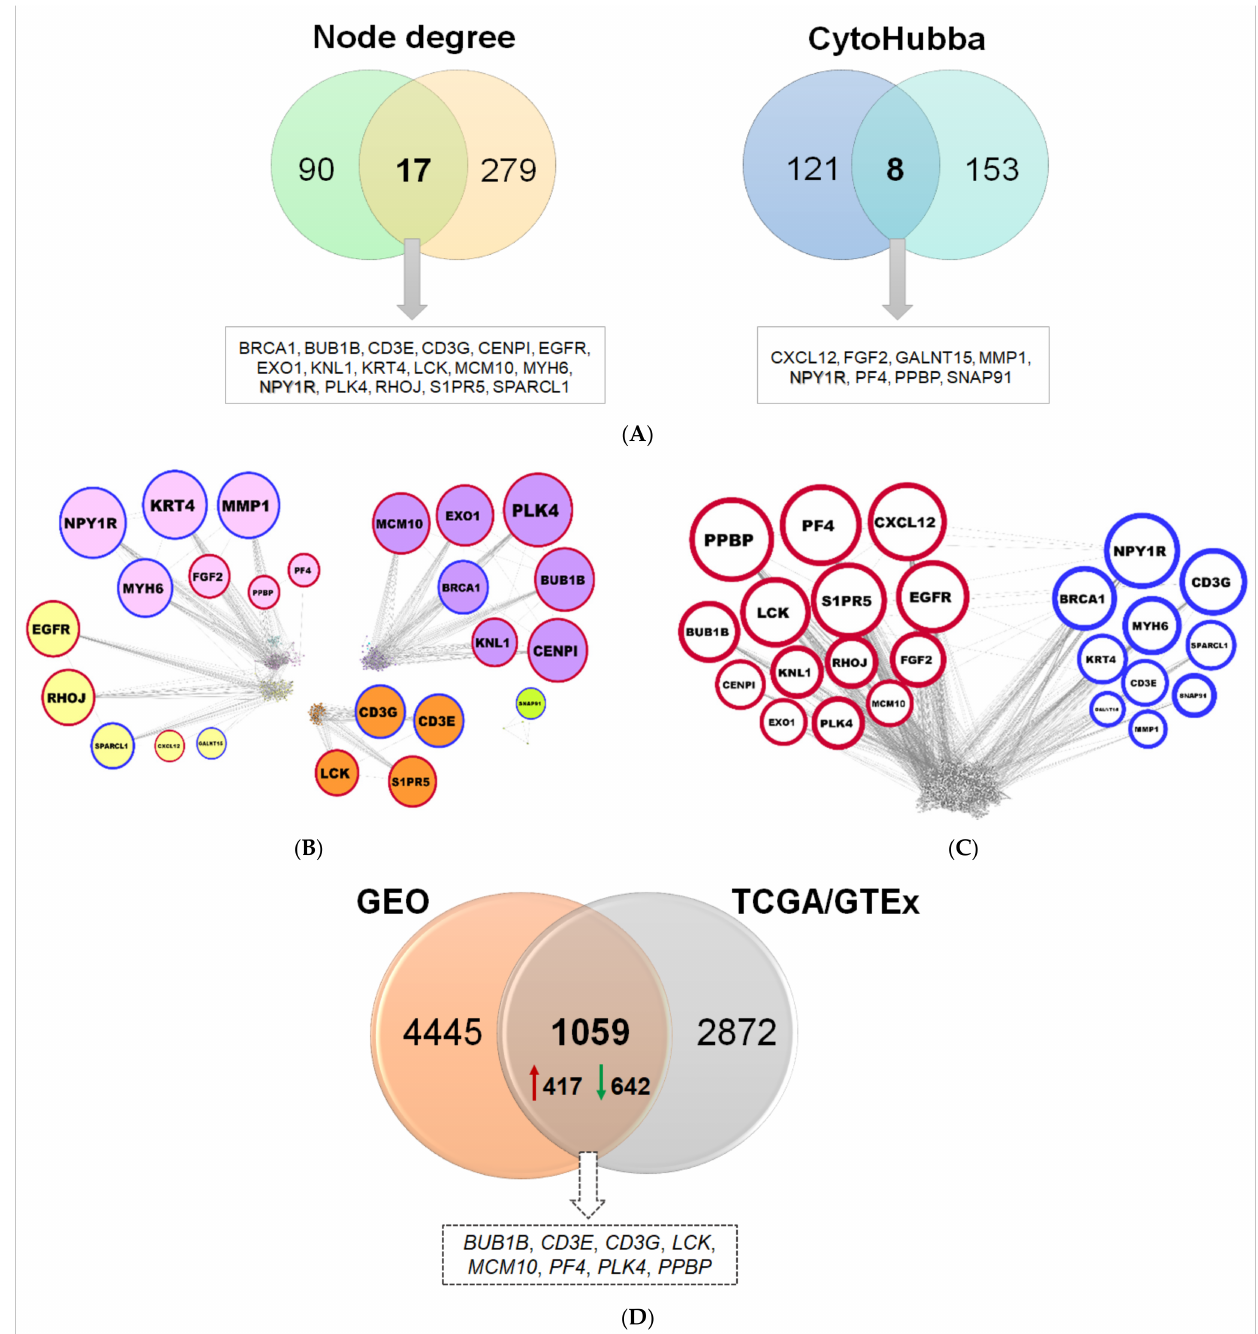
Figure 4. Important nodes identified through gene co-expression and PPI network. ( A ) Venn diagrams depicting the common nodes between the co-expression and PPI networks according to node degree and cytoHubba, respectively. ( B ) Co-expression network showing the 24 common genes, as distributed in pink, magenta, yellow, brown, and greenyellow modules. The nodes correspond to genes and the edges (connecting lines) represent the associations among genes. The size of the nodes is proportional to the number of their immediate connections (degree of connectivity). Red and blue border lines indicate up- and downregulation, respectively. ( C ) PPI network with the 24 common proteins. ( D ) Venn diagram for validation of diagnostic signatures, showing the common DEGs between the TCGA/GTEx and the two merged GEO